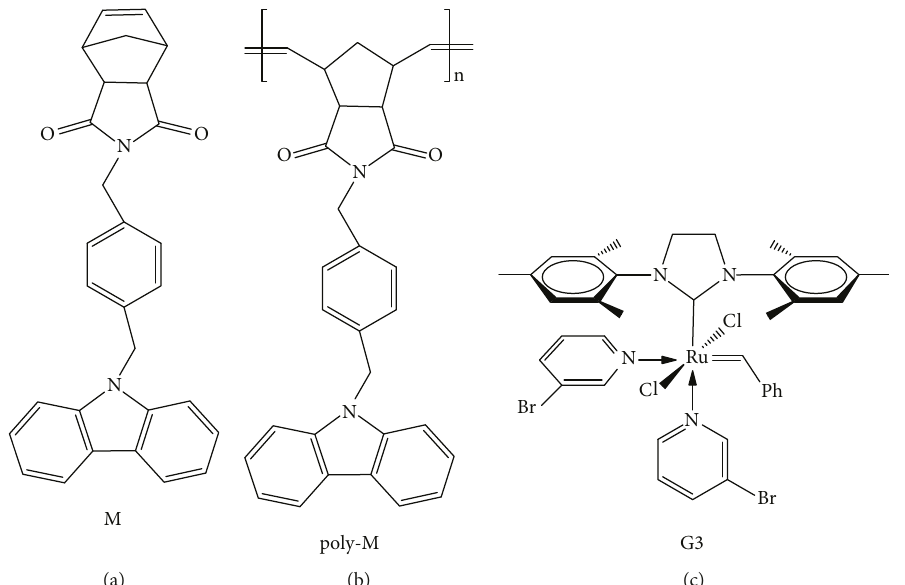
Figure 1: (a) Structure of (2-(4-((9H-carbazole-9-yl)methyl)benzyl)-3a,4,7,7a-tetrahydro-1H-4,7-methanoisoindole-1,3(2H)-dione) ( M ). (b) Structure of poly(2-(4-((9H-carbazole-9-yl)methyl)benzyl)-3a,4,7,7a-tetrahydro-1H-4,7-methanoisoindole-1,3(2H)-dione) (poly- M ). (c) Grubbs third generation catalyst ( G3